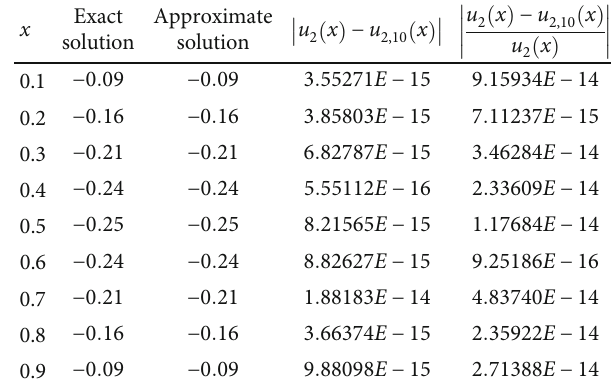
x Þ for Example 1. Table 2: The numerical solutions of u 1 ð